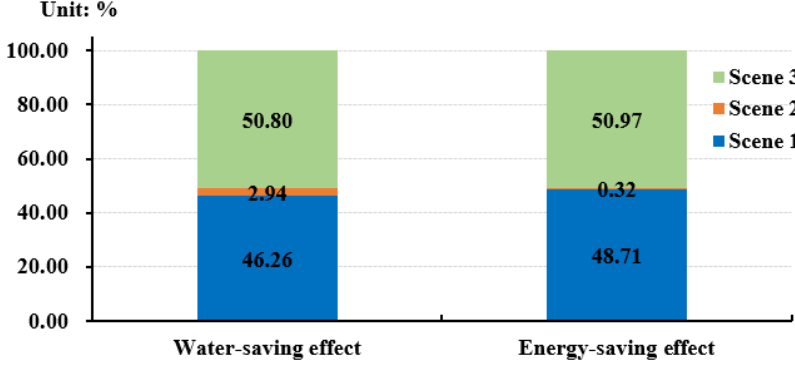
Figure 9. The effects of water saving and energy saving in various scenarios.